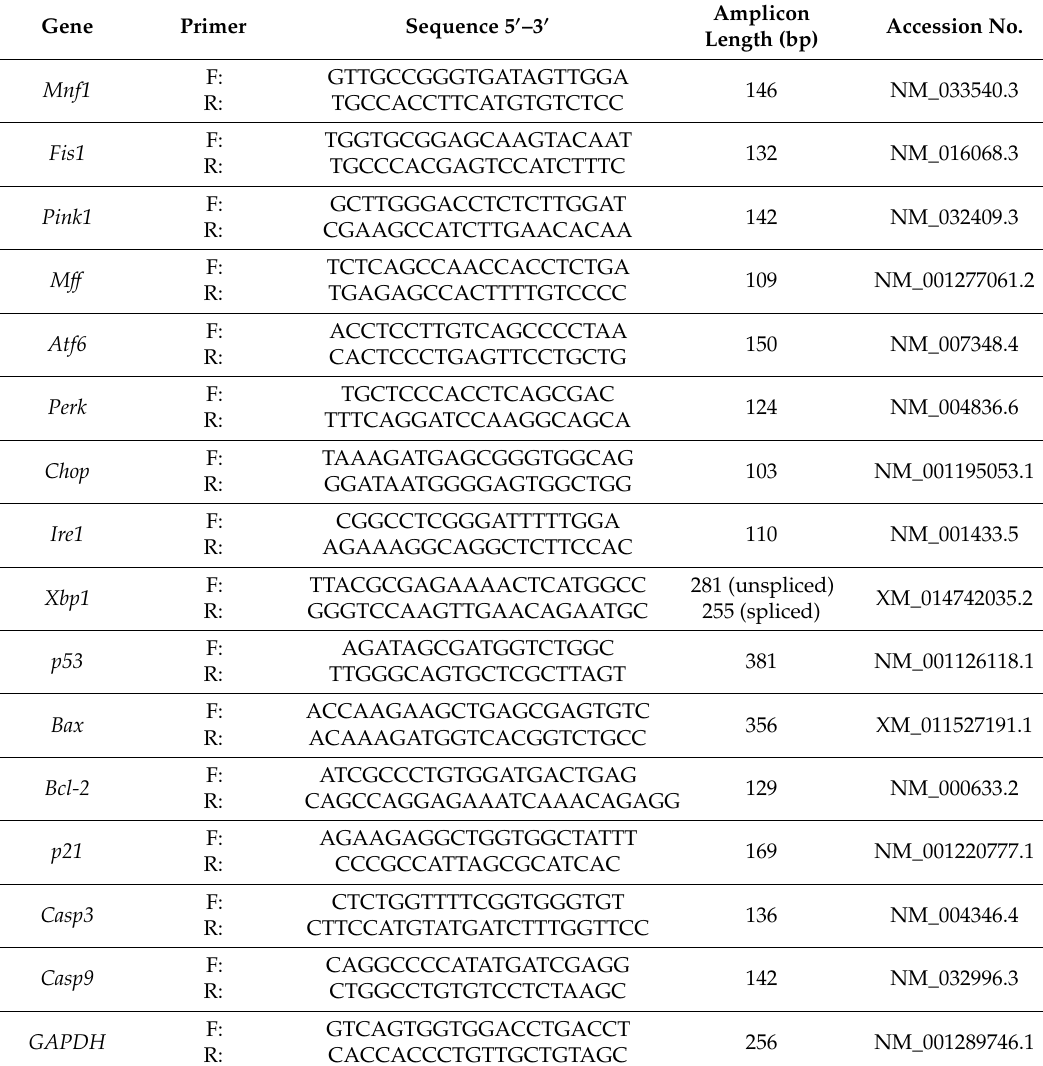
Table 1. Sequences of primers (Sigma Aldrich, Pozna´n, Poland) used in